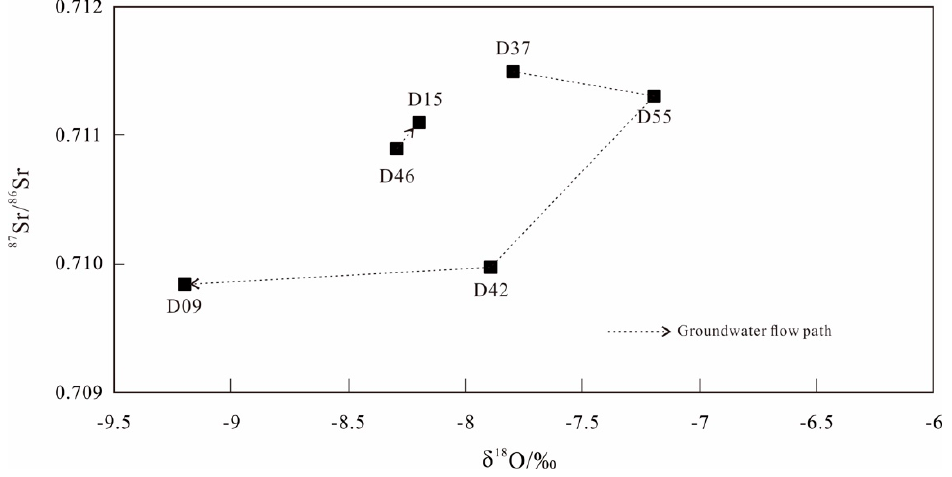
Figure 6. Plot of the 87 Sr/ 86 Sr ratio versus δ 18 O.